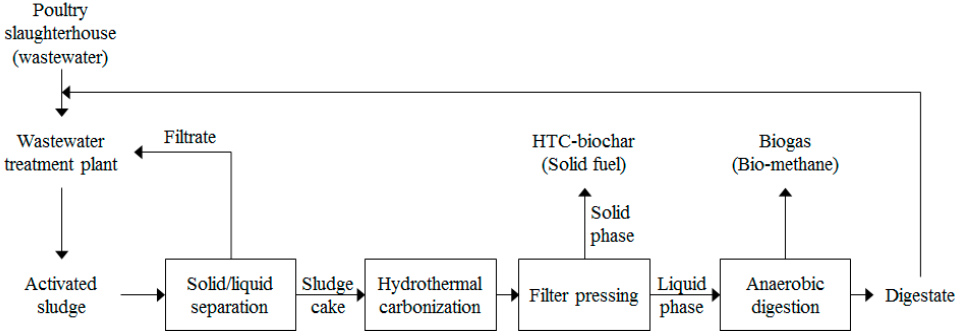
Figure 1. Scheme of the HTC (Hydrothermal carbonization) system for the energy conversion of sludge cake generated at the poultry slaughterhouse wastewater treatment plant. cake generated at the poultry slaughterhouse wastewater treatment